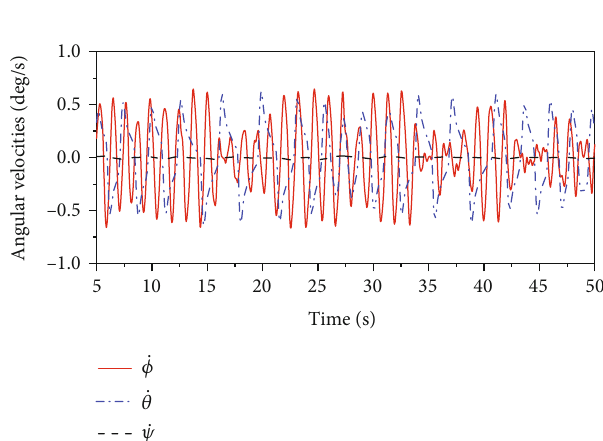
Figure 15: Linear velocities in time history.